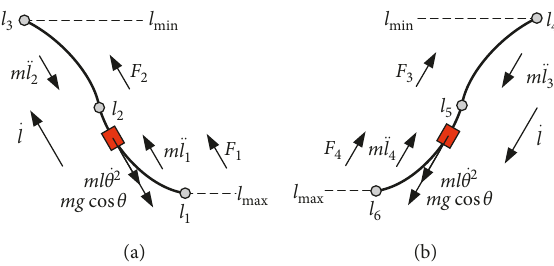
Figure 3: Radial forces acting on the mass. (a) The mass upward process; (b) the mass downward